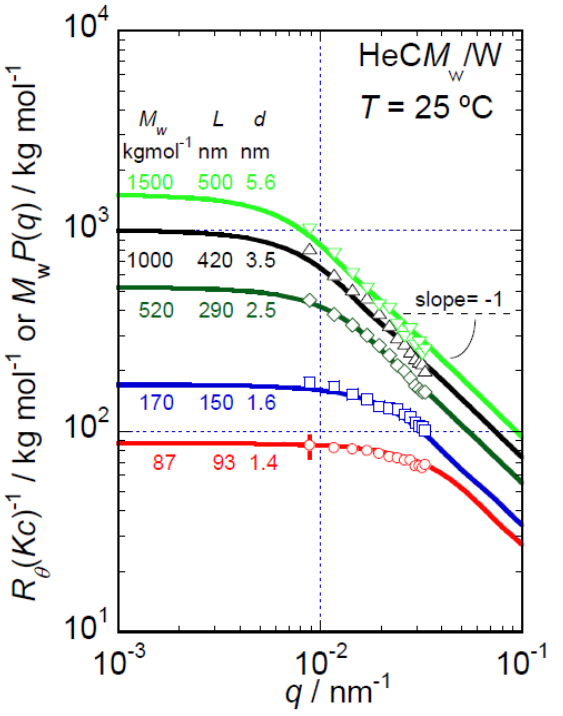
Figure 3. q dependencies of the R θ ( Kc ) −1 c =0 data and fitted M w P ( q ) curves for HeC samples in aqueous solution at 25 °C.